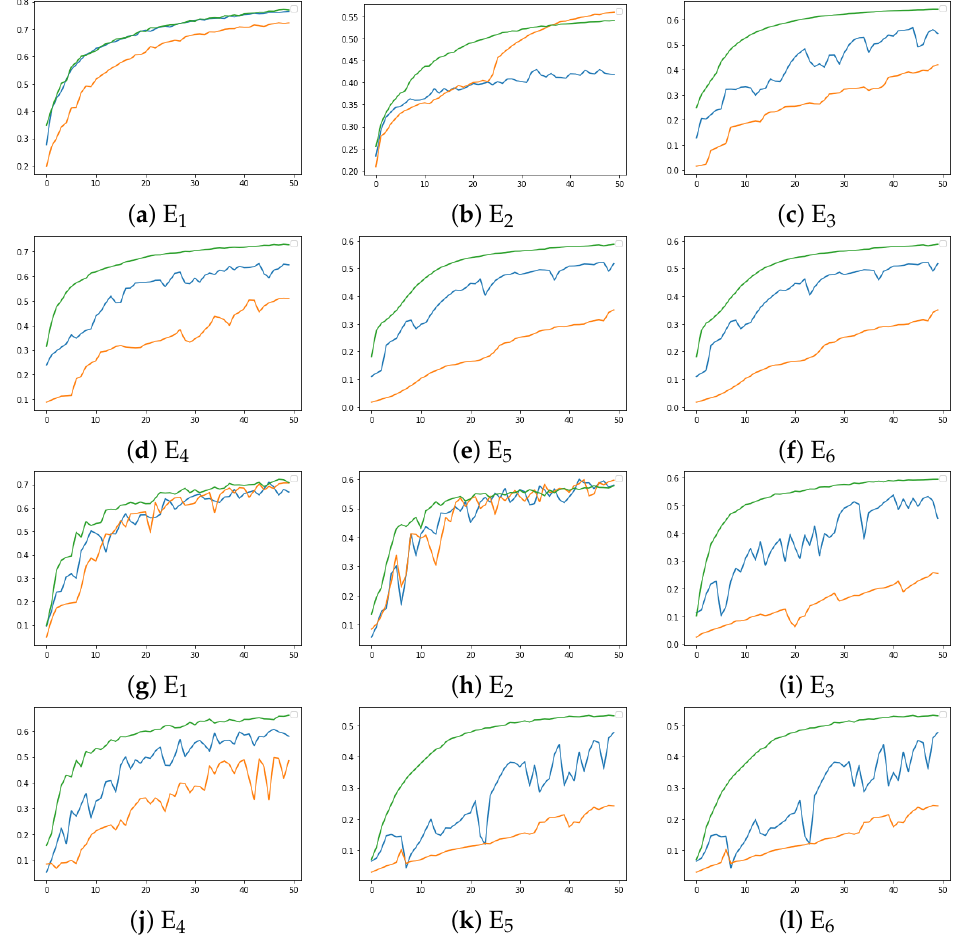
Figure 11. Convergence analysis of different sampling methods. Green: Irrelevance sampling; Blue: Random sampling; Orange: AFL sampling. ( a – f ): IID condition and ( g – l ): Non-IID condition. FEMNIST dataset and FedAvg learning schemes are